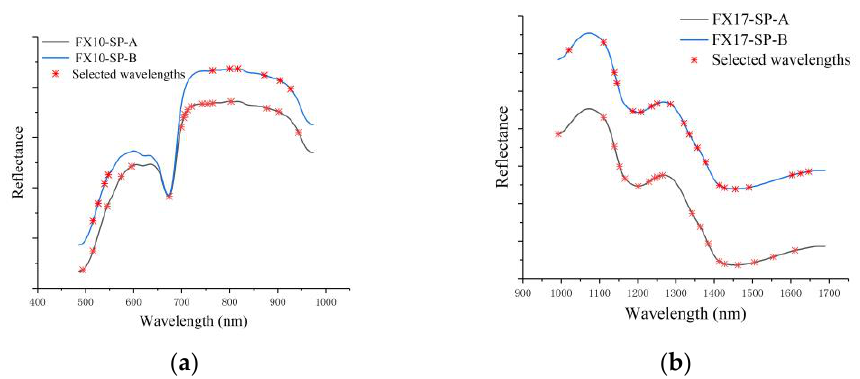
Figure 4. Characteristic wavelengths obtained with SPA. ( a ) Selected wavelengths of VIS/NIR spectra including SP-A and SP-B; ( b ) selected wavelengths of NIR spectra including SP-A and SP-B. (Note: Given that the average spectra of the two sides partially overlap and are not convenient for observation, the reflectance values of the SP-B spectra of FX10 were averaged and increased by 0.01, and the reflectance values of the SP-B spectra of FX17 were averaged and increased by 0.001).